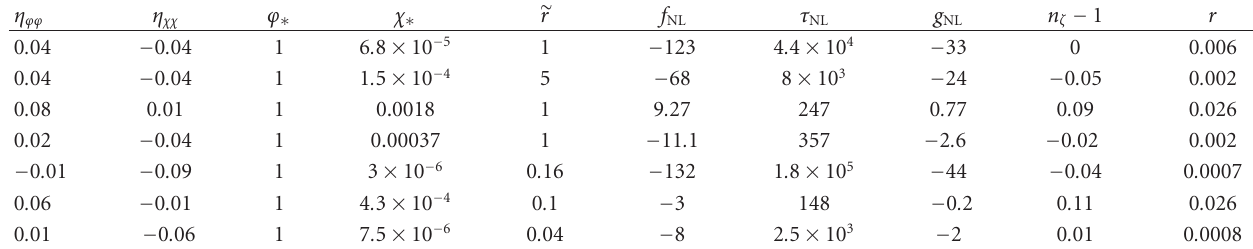
Table 1: Table showing some initial conditions for the hybrid inflation model that lead to large levels of non-Gaussianity. The table shows the parameter (cid:11) r , the bispectrum and the trispectrum nonlinearity parameters, the spectral index and tensor-to-scalar ratio. They are evaluated when the number of e -foldings from the end of inflation is N k = 60. The trispectrum parameters τ NL and g NL are defined and calculated in Section